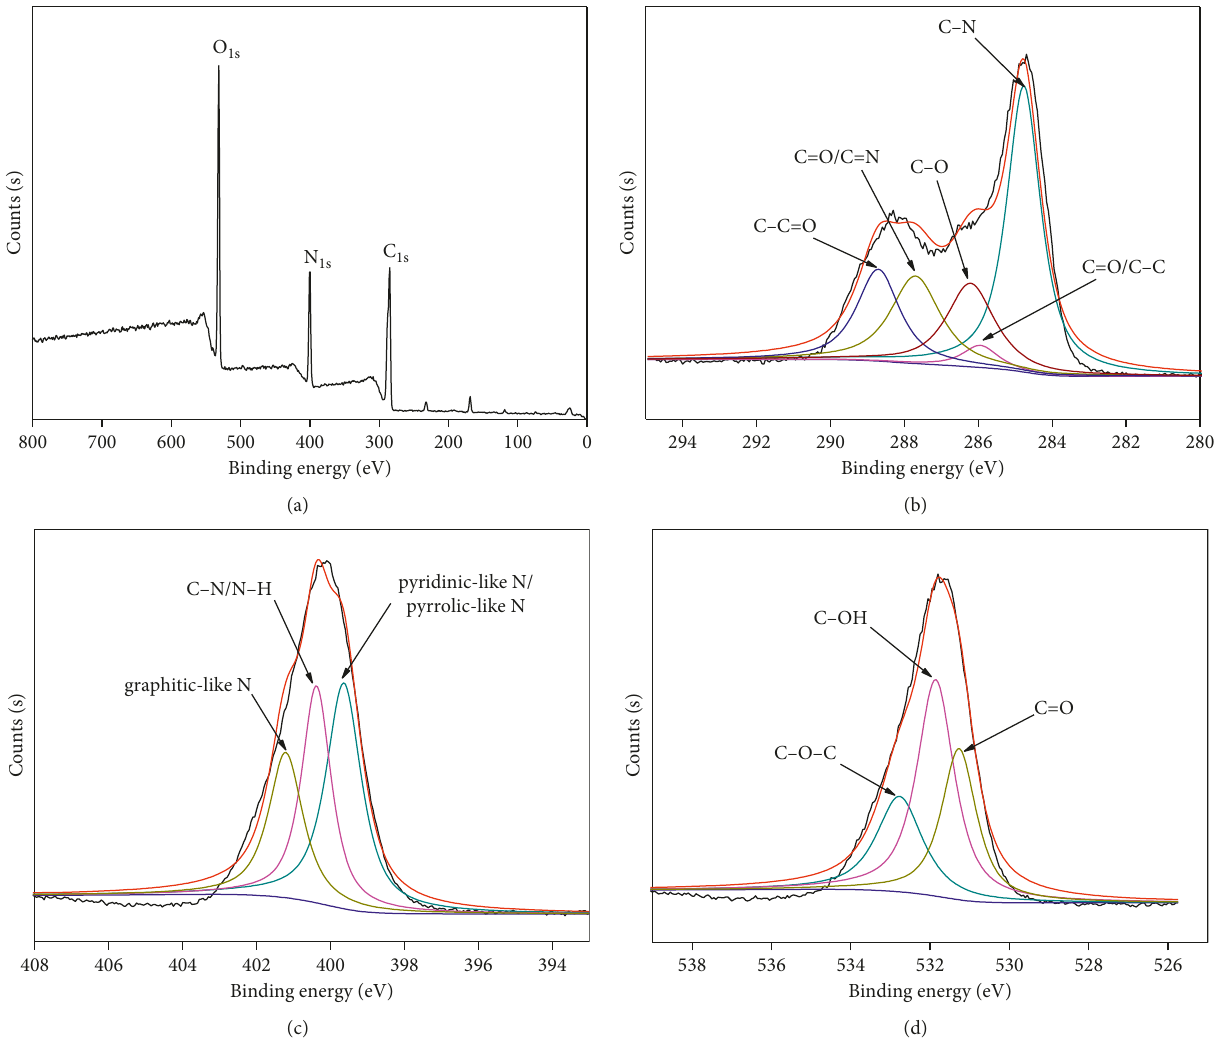
Figure 3: (a) XPS, (b) C 1s , (c) N 1s , and (d) O 1s spectra of the obtained NRPCNSs.